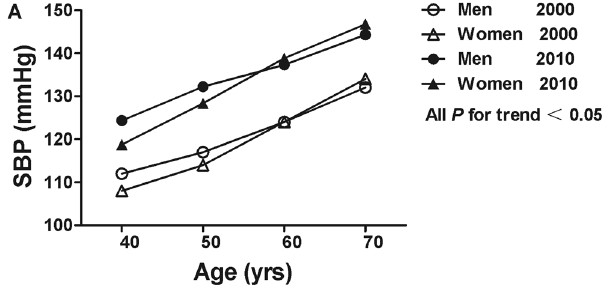
Figure 1. Mean systolic blood pressure (SBP) across age groups by sex in 2000 and 2010.